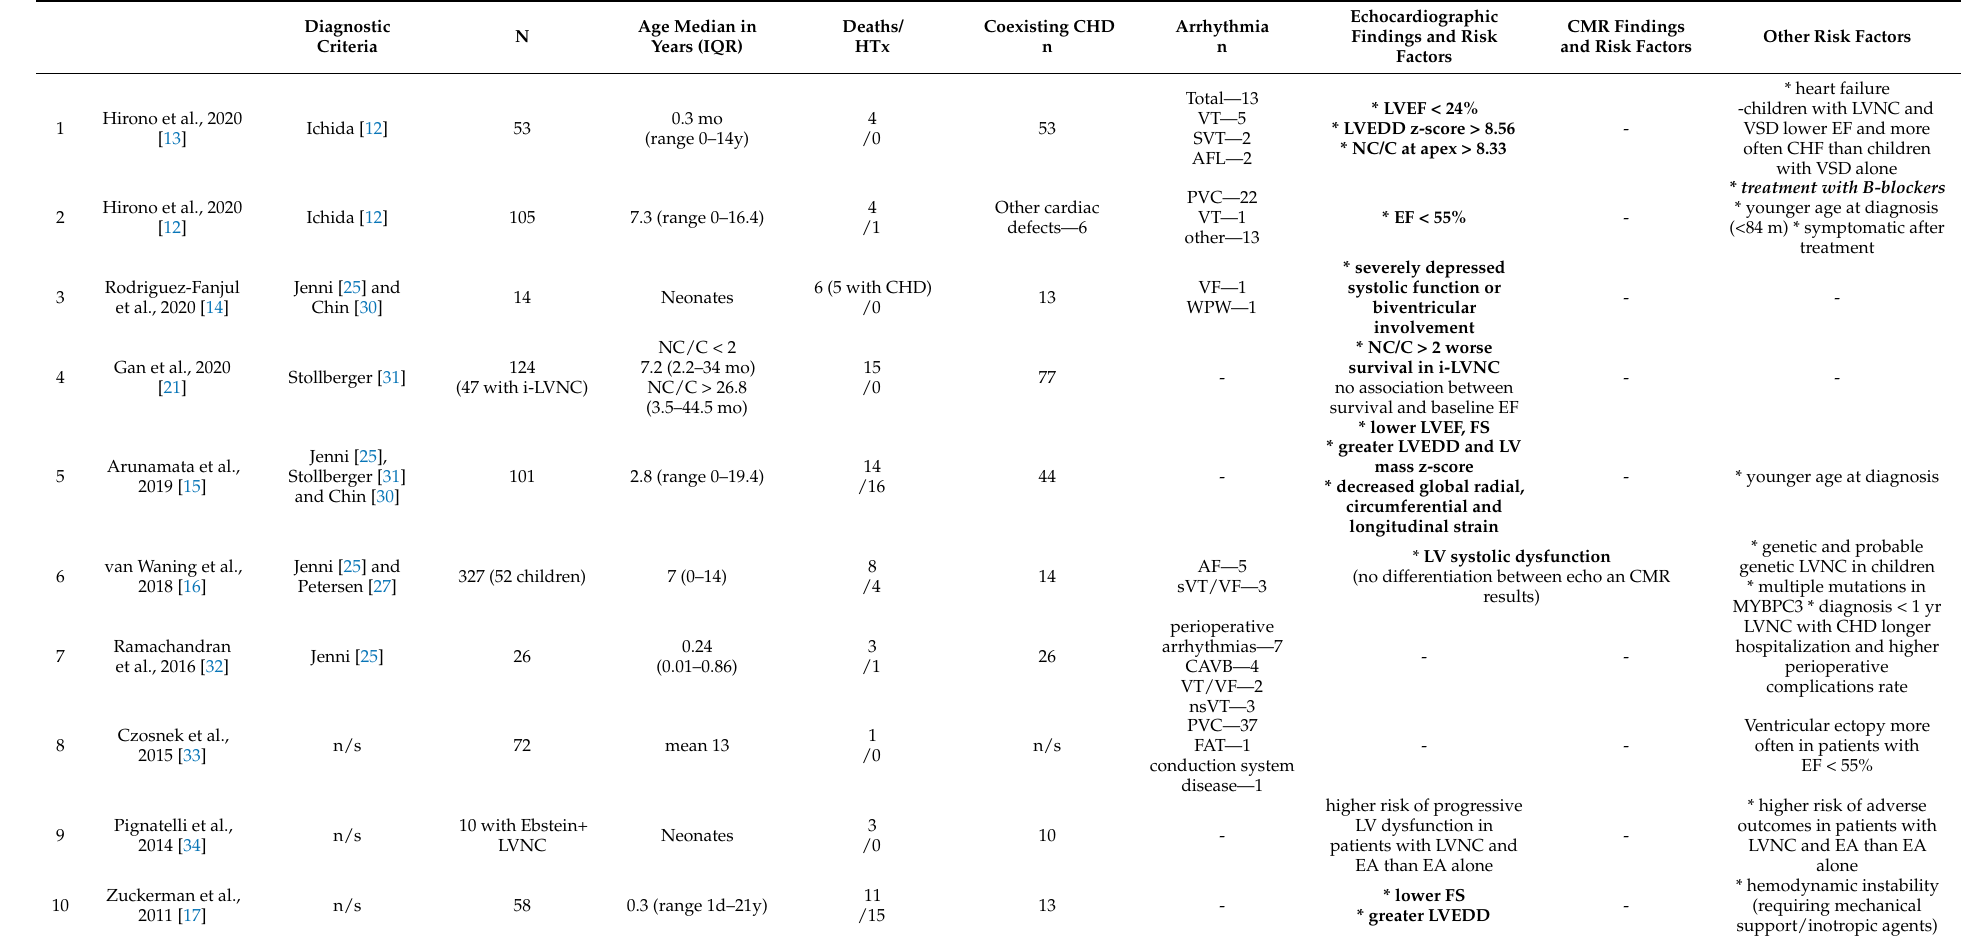
Table 2. Characteristics of patients with congenital heart diseases, as well as echocardiographic, CMR, and other risk factors for unfavorable